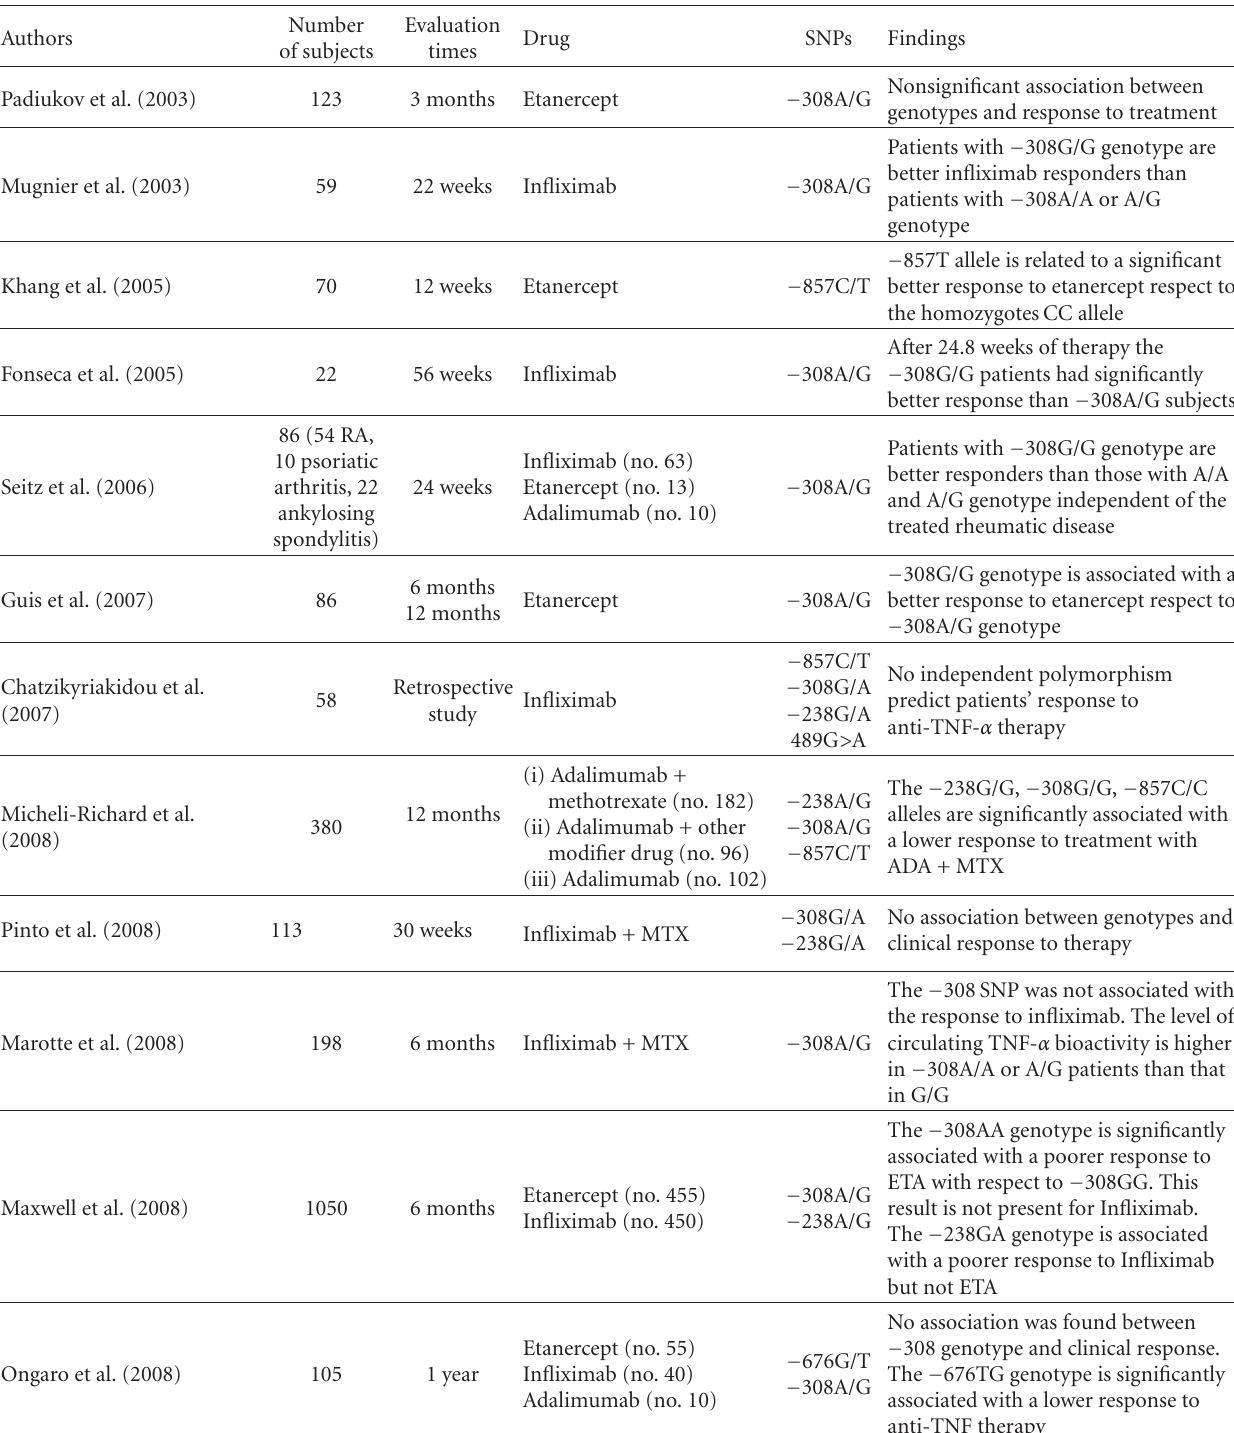
Table 3: TNF- α SNPs and RA anti-TNF α therapeutic